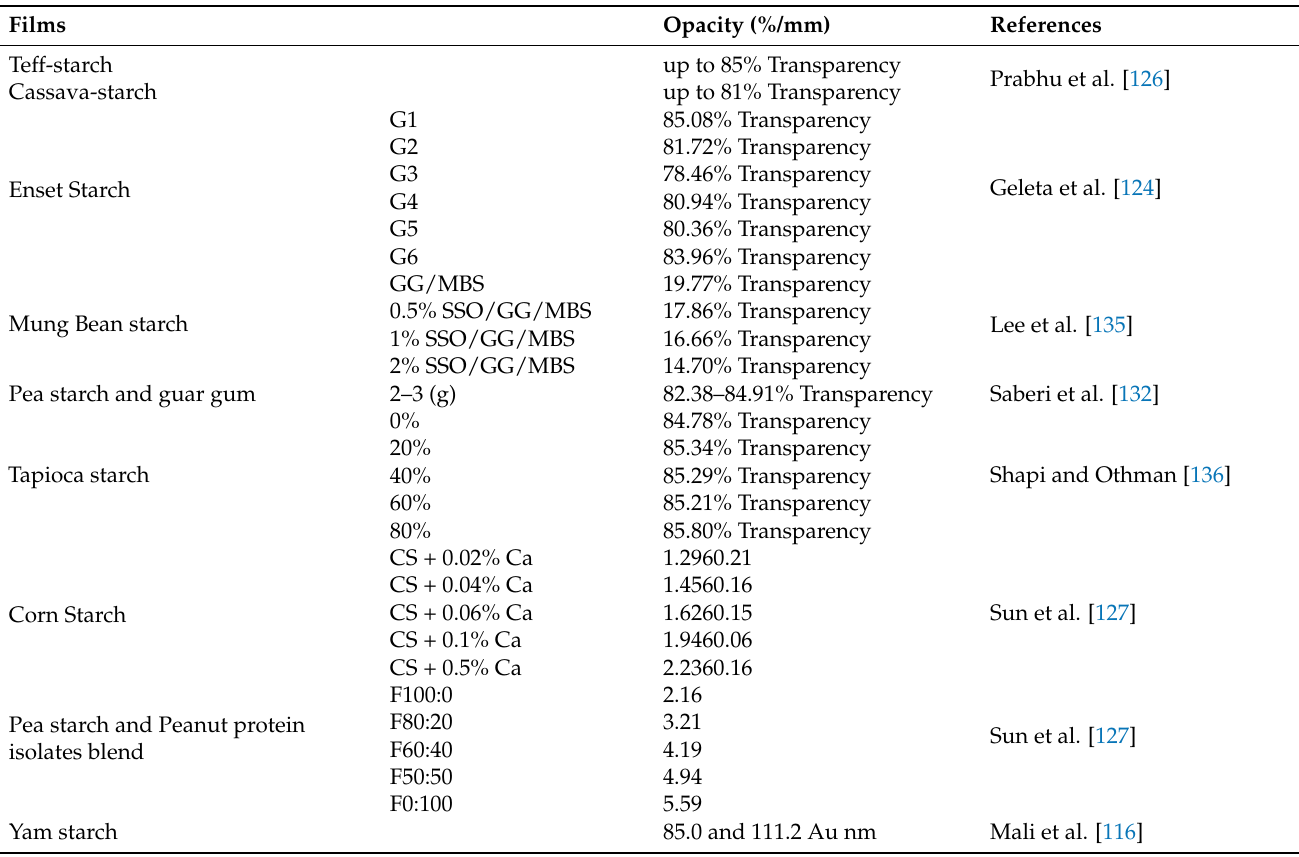
Table 3. Optical parameters of starch-based